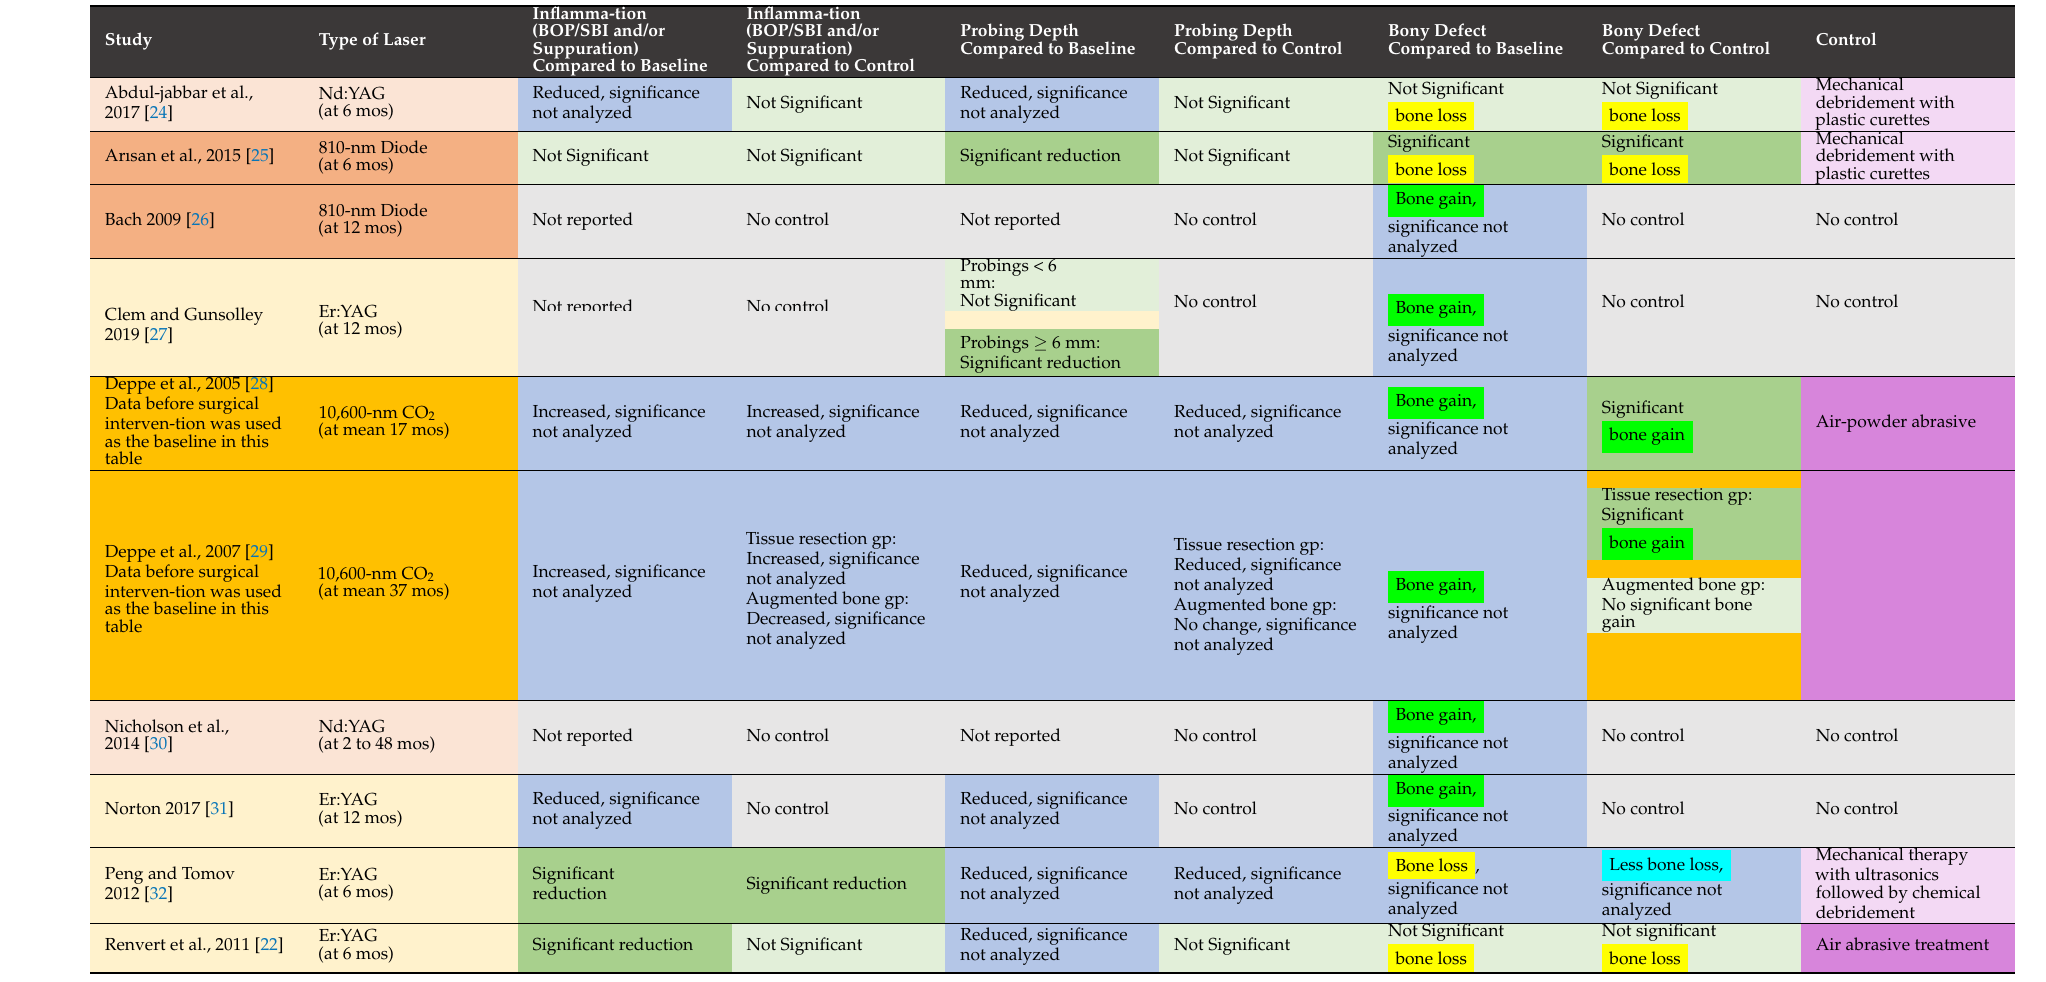
Table 8. Clinical significance of laser therapy ≥ 6 months